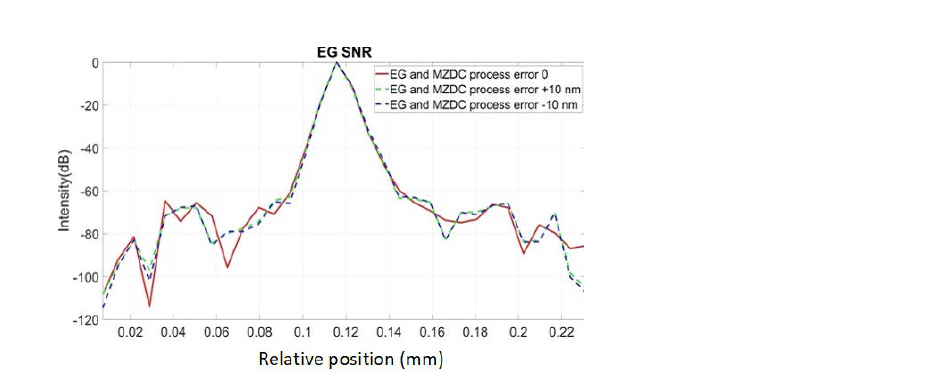
Figure 12. PSF from the MZDC interrogated with EG.